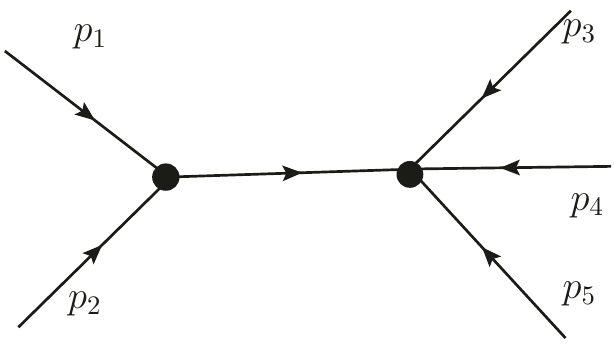
Figure 18. This diagram de(cid:12)nes J ( p 1 ; p 2 ; p 3 ; p 4 ; p 5 ) in (B.30).